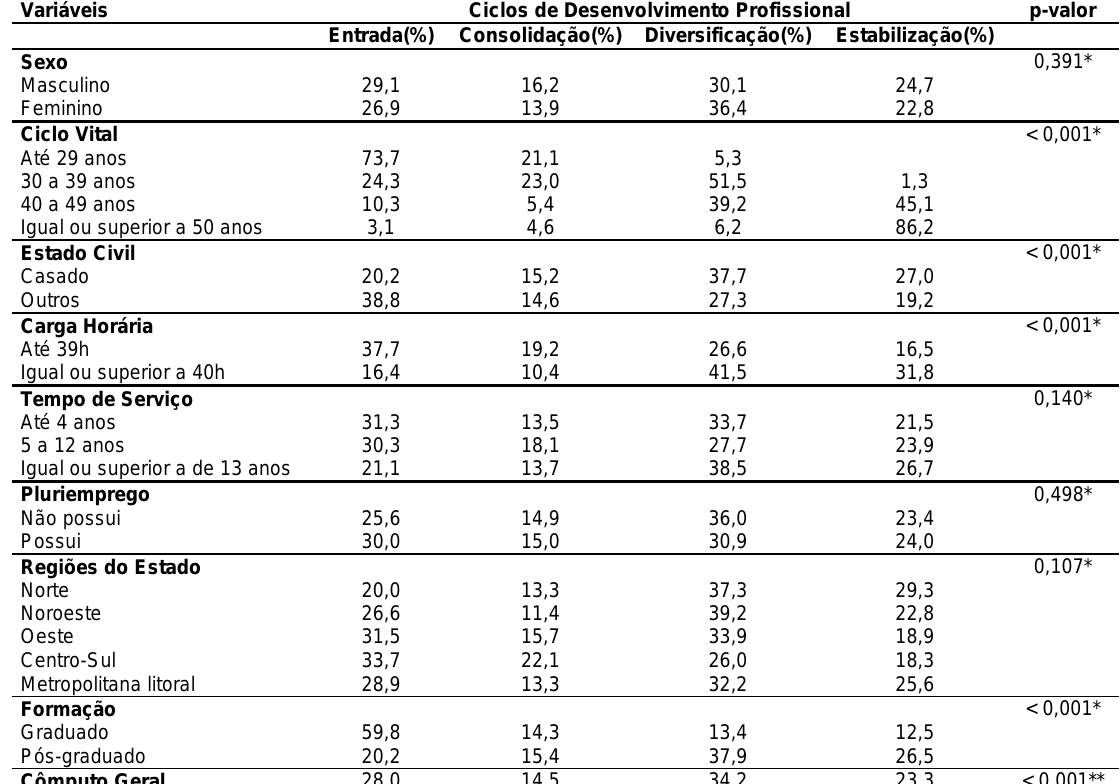
Tabela 1. Características Sociodemográficas considerando os Ciclos de Desenvolvimento